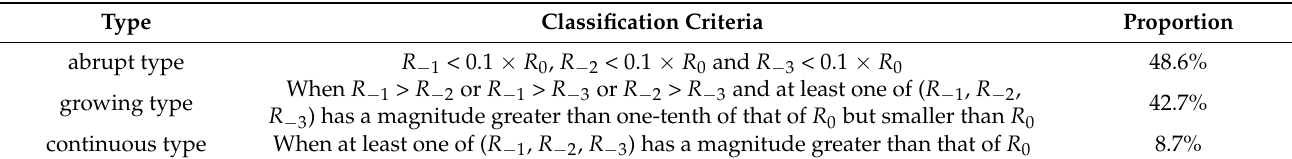
Table 4. Classification criteria and proportions of different types of ExHP events in Shenyang.